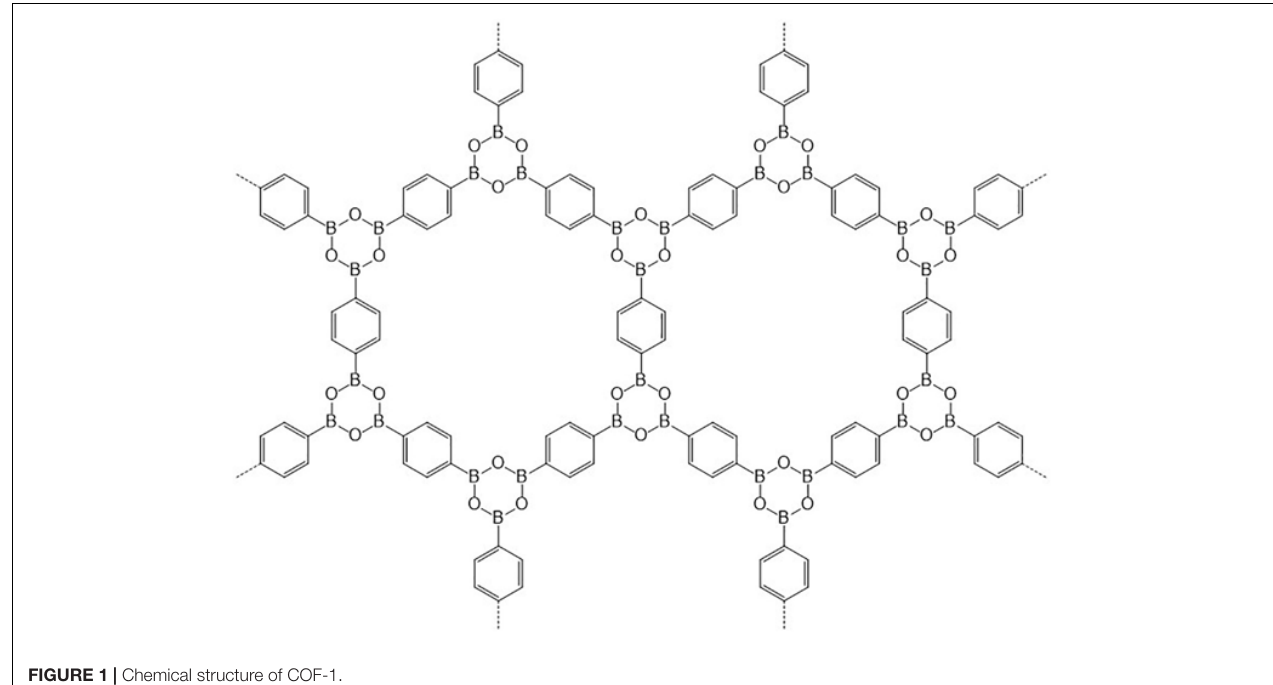
FIGURE 1 | Chemical structure of COF-1.